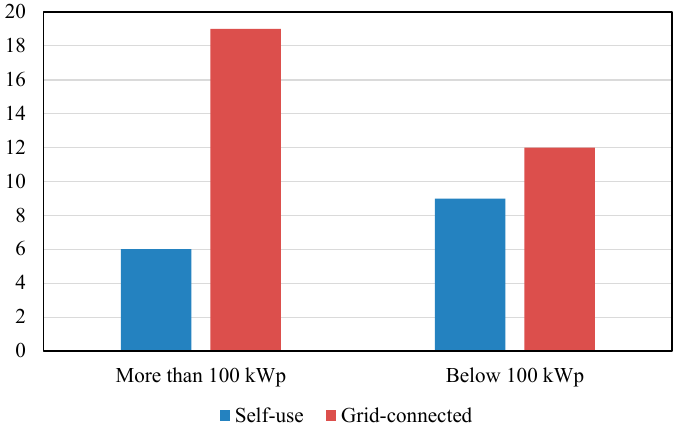
Figure 5. Distribution of PV grid-connected projects.